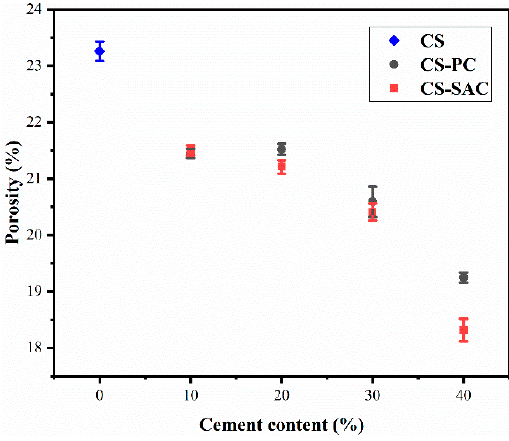
Figure 4. Porosity of blended mortars at 28 days.